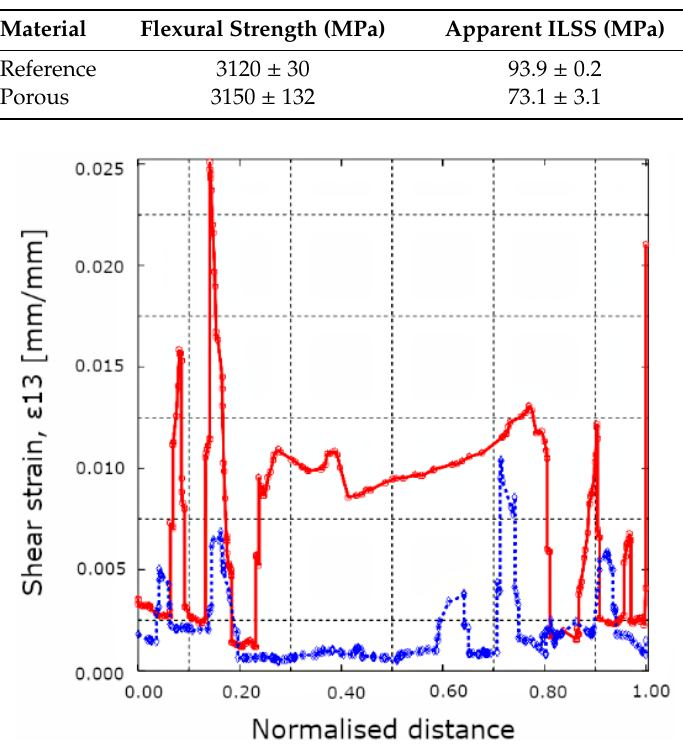
Table 5. Comparison of strengths in defective and pristine samples.